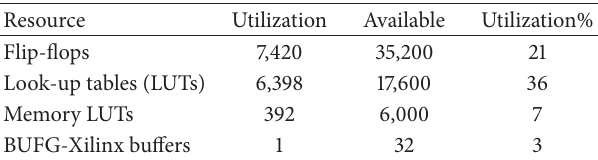
Table 8: Postimplementation resources for Table 6 from the Vivado 2014.4